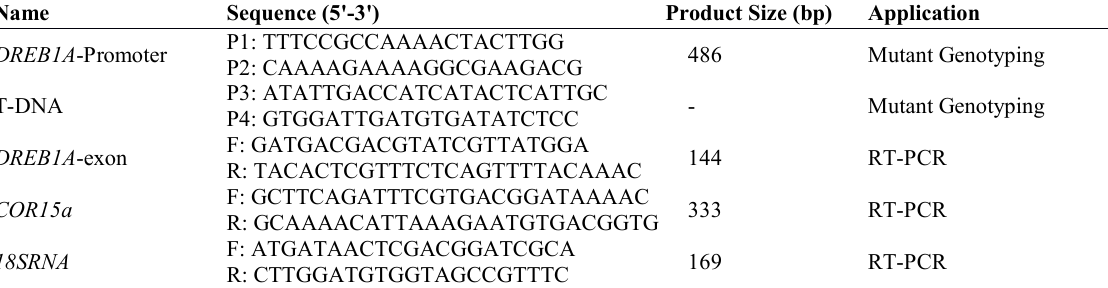
Table 1. The list of primers used for T-DNA genotyping and expression